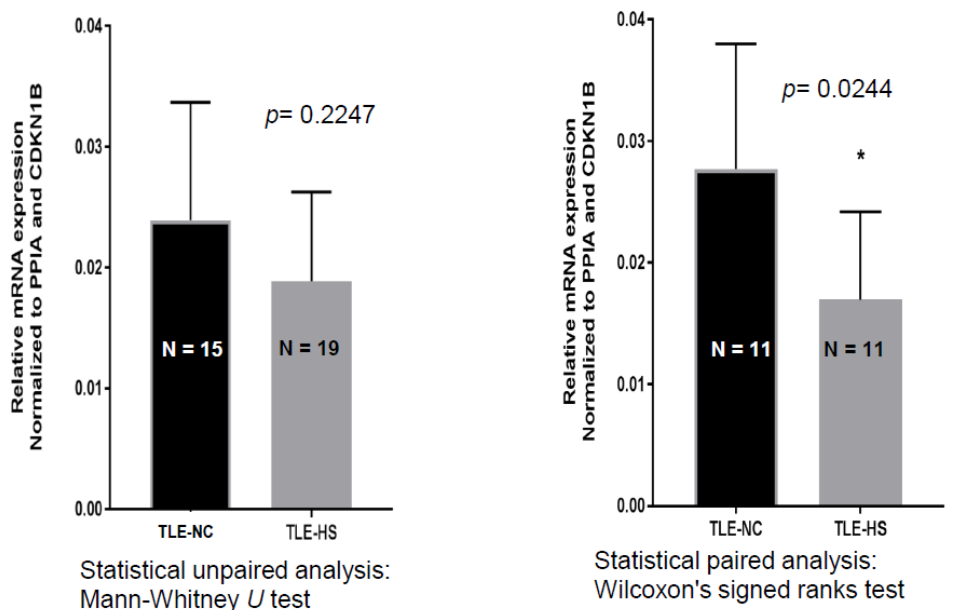
Figure 1. Relative expression level (2 − ∆ Ct ) of SCN4B gene, determine using RT-qPCR, in hippocampal sclerotic and non-sclerotic tissue samples of each patient. Left panel: unpaired samples. Right panel: paired samples. Gene expression levels were calculated using the Ct values of each sample and normalized to the house-keeping genes (PPIA and CDKN). Data are means ± SD, where n = 3 for control and epileptic samples of each patient.